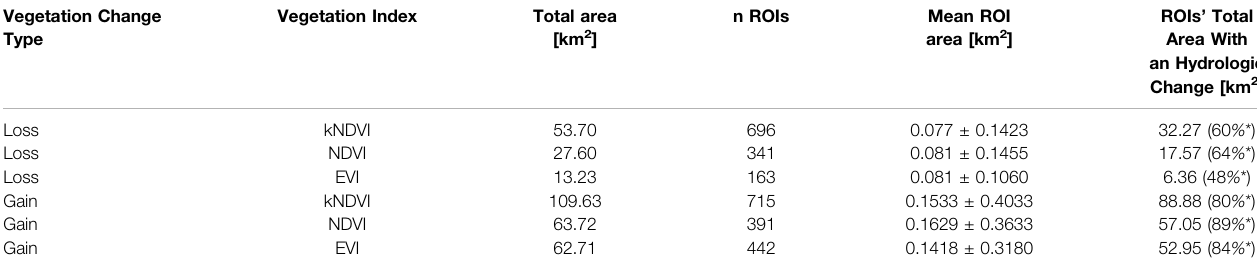
TABLE 1 | Spatial extension of loss and gain with the three indices. The asterisk refers to the percentage of ROIs ’ total area with a hydrologic change. Vegetation Change